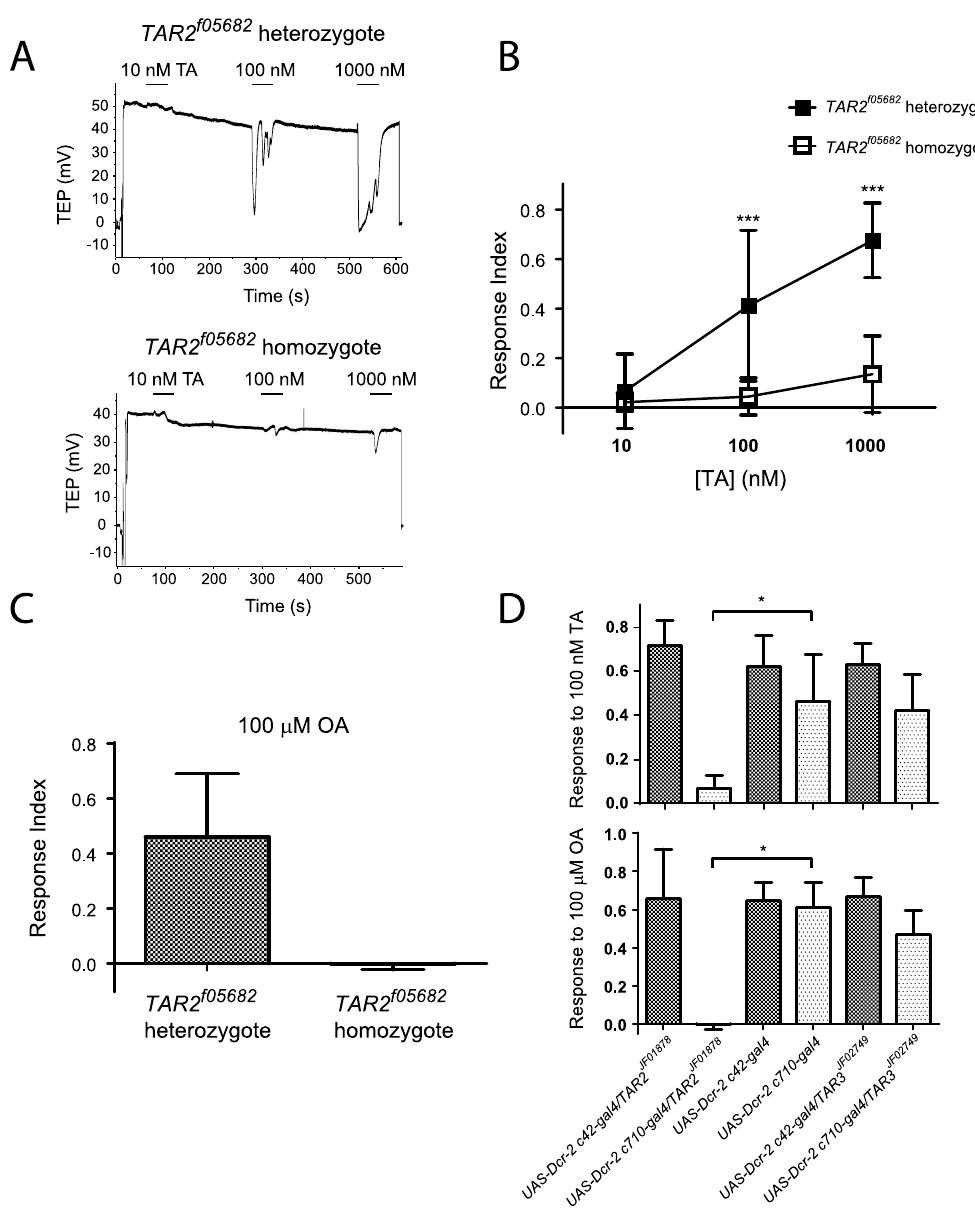
Figure 2. ( A ) Representative responses to 10, 100, and 1000 nM TA of a TAR2 f05682 heterozygote (upper trace) and homozygote (lower trace). ( B ) Dose-response curve for TA in TAR2 f05682 heterozygotes and homozygotes. *** Significant difference between genotypes, p < 0.001, 2-way ANOVA and Bonferroni post-test, n = 8–10 tubules per genotype. ( C ) Response of TAR2 f05682 heterozygotes and homozygotes to 100 μ M OA. The average response amplitude of homozygotes does not differ from zero, 1-sample t-test, p = 0.76. n = 9 tubules per genotype. ( D ) Effect of TAR2 and TAR3 RNAi on responses to 100 nM TA (upper graph) and 100 μ M OA (lower graph). The responses of RNAi tubules were compared to those of the appropriate parental line by Kruskal- Wallis and Dunn’s multiple comparison tests. Asterices indicate that the only difference seen was upon RNAi of TAR2 in the stellate cells. Knockdown of TAR2 in the stellate cells did not eliminate the response to TA (1-sample t-test, p = 0.01) but did eliminate the response to OA (p = 0.82). n = 8–11 tubules per